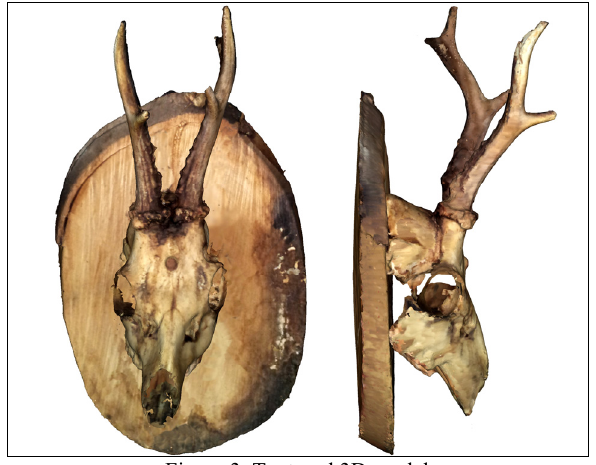
Figure 3. Textured 3D model